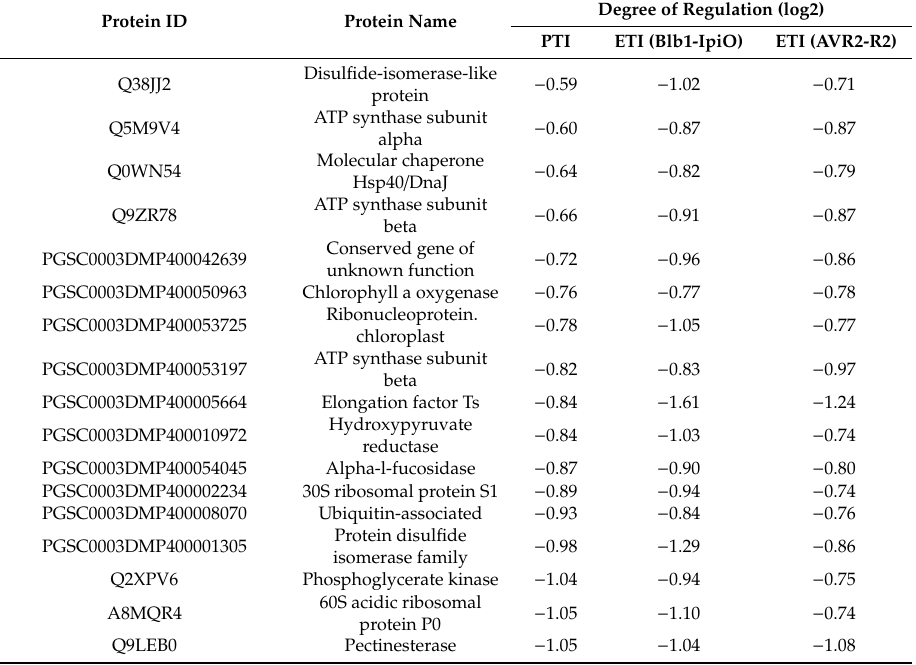
Table 2. Proteins with decreased abundance from PTI and ETI interactions, 18 hpi (hours post infiltration). A comparison was made between the immune-treated plants and the control plants infiltrated with medium only. All values are in log2 fold. Non-significant p values are indicated by NA. All p -values < 0.01 are shown in the